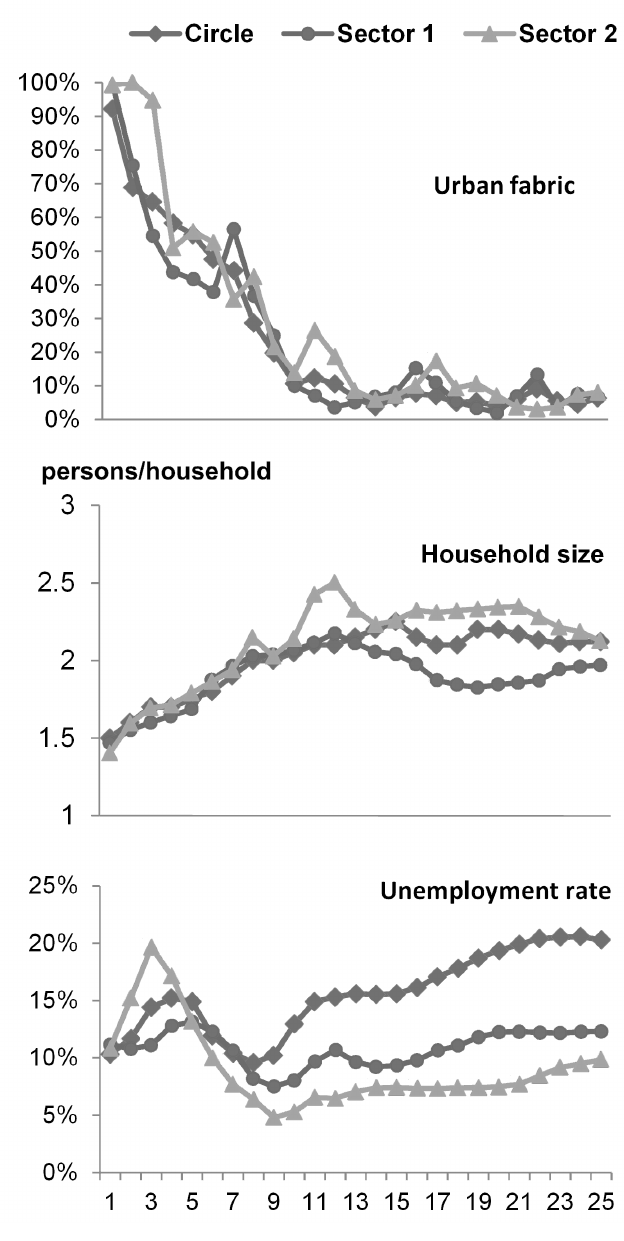
Figure 7: Gradients of the six socioeconomic items in the circle and sector areas of the Leipzig urban-rural area. The X-axis is the distance in kilometers from the city center of Leipzig. The Y-axis is the average value of the socioeconomic indicators in the associated concentric ring or concentric sector ring of the circle or sectors. Road density and urban fabric are for 2006 and the other four indicators are for 2005 (after Kroll and Kabisch,